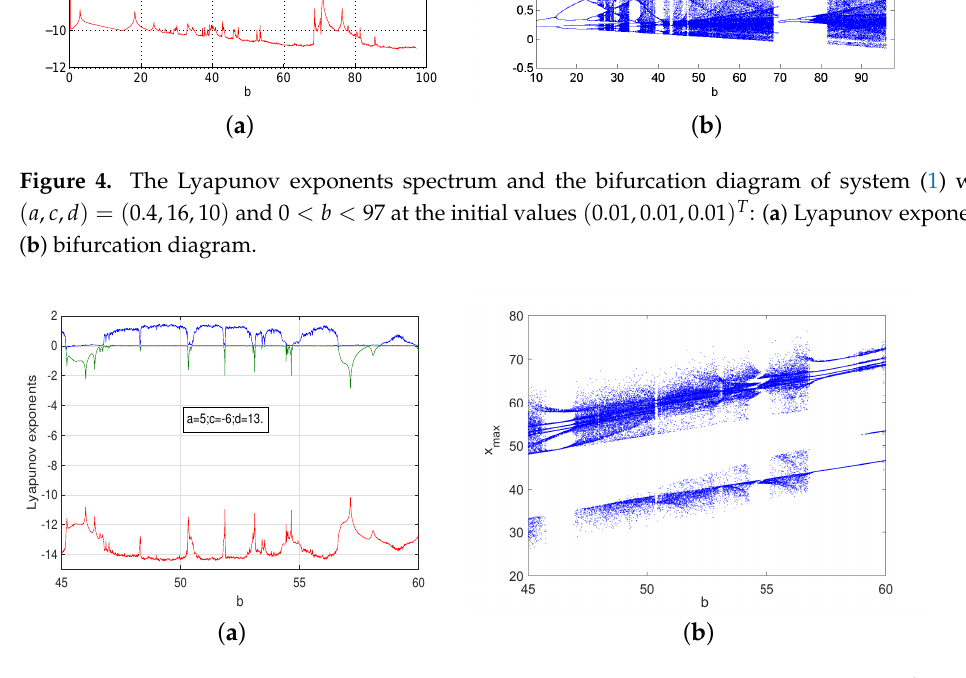
Figure 5. The Lyapunov exponents spectrum and the bifurcation diagram of system (1) with ( a , c , d ) = ( 5, − 6,13 ) and 45 < b < 60 at the initial values ( 50.01,7.31,5.01 ) T : ( a ) Lyapunov exponents; ( b ) bifurcation